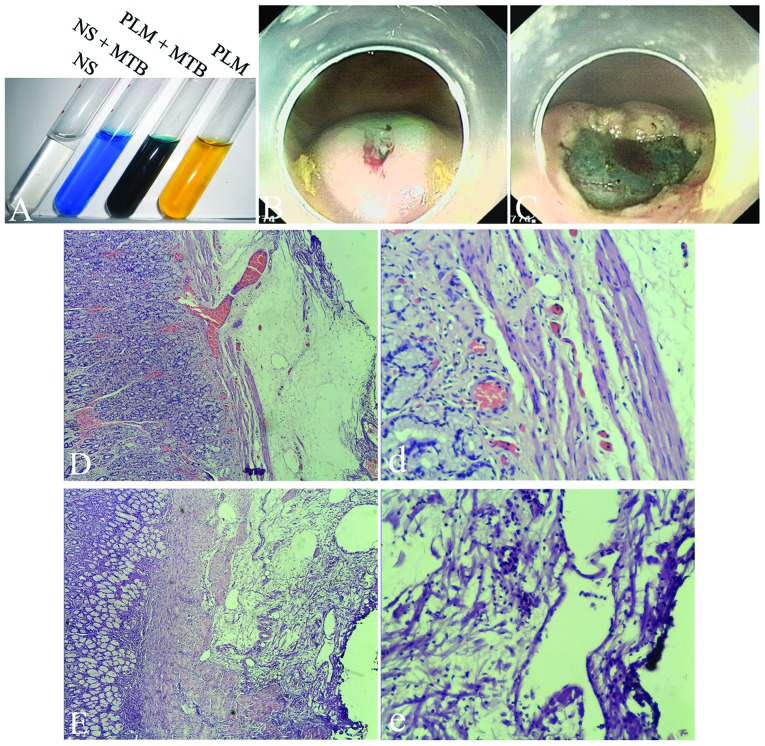
ESD procedures in pig stomachs and tissue damage evaluation following ESD. (A) Different color of injection agents; NS, normal saline; MTB, methylene blue; PLM, plasma. (B) Submucosal injection with plasma. (C) After ESD by plasma injection. (D and d) Marked hydrops and hyperemia were observed from submucosal to mucosa surface after submucosal injection with normal saline. (E and e) Marked demarcated separation of the mucosa and the muscularis propria and uniform distribution (or tears) in the loose submucosa were observed following injection with 50% plasma solution. Magnification: D and E, ×100; d and e, ×400. ESD, endoscopic submucosal dissection.